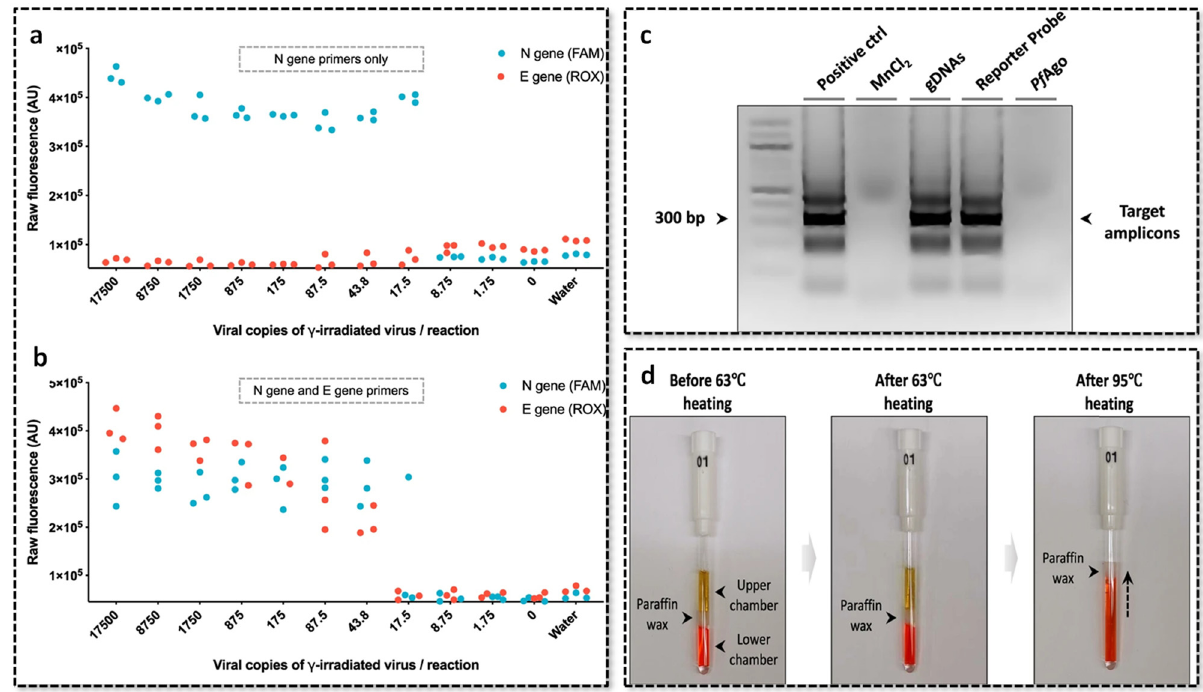
Figure 2: SPOT assay optimization and validation: ( a ) LOD with RNA, ( b ) multiplexity of the test, and ( c ) LAMP response is a ff ected by PfAgo detection. ( d ) The top chamber ( yellow liquid represents the RT - LAMP reaction ) is separated from the bottom chamber [ 42 ]